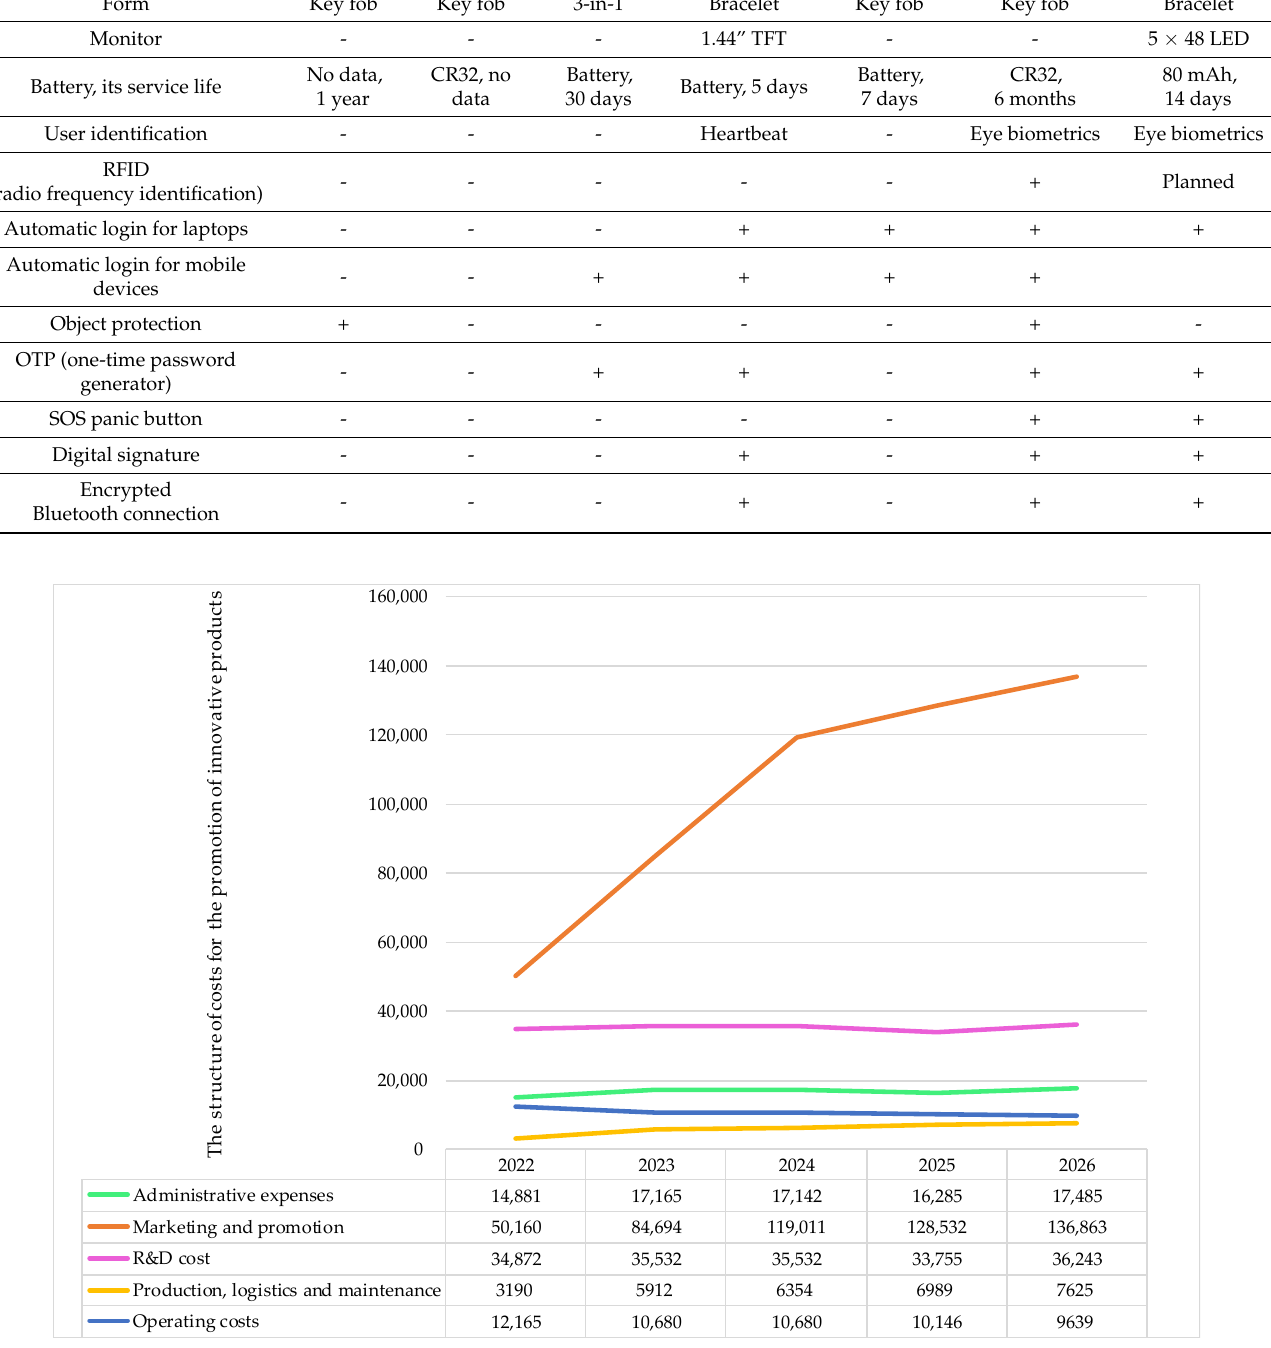
Figure 5. Dynamics of planned revenue from the implementation of Hideez Key in 2022–2026, US dollars. The dynamics of the projected gross profit of Hideez Technology in 2022–2026 will be achieved at the expense of B2C and B2B segments (prepayment and license) (Figure 6).